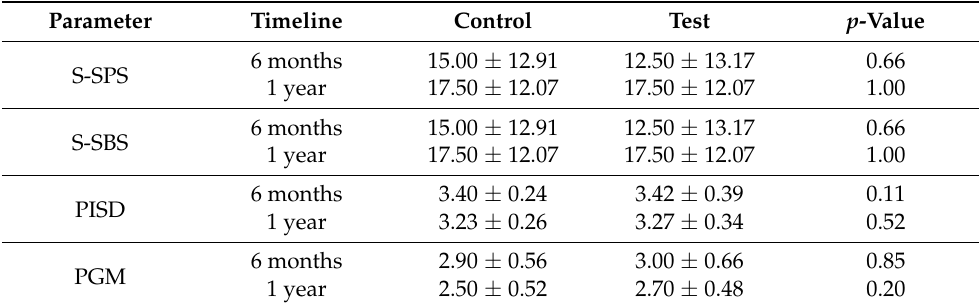
Table 2. Intergroup comparison of clinical parameters at 6 months and 1 year. Parameter